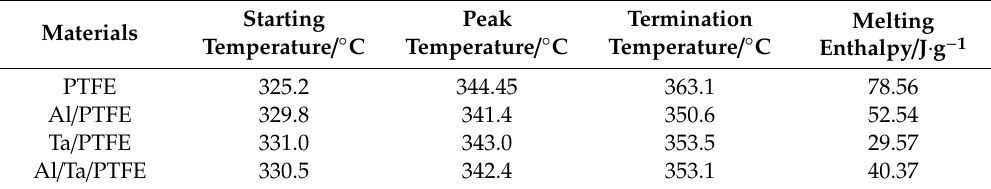
Table 2. The information on peak A of four